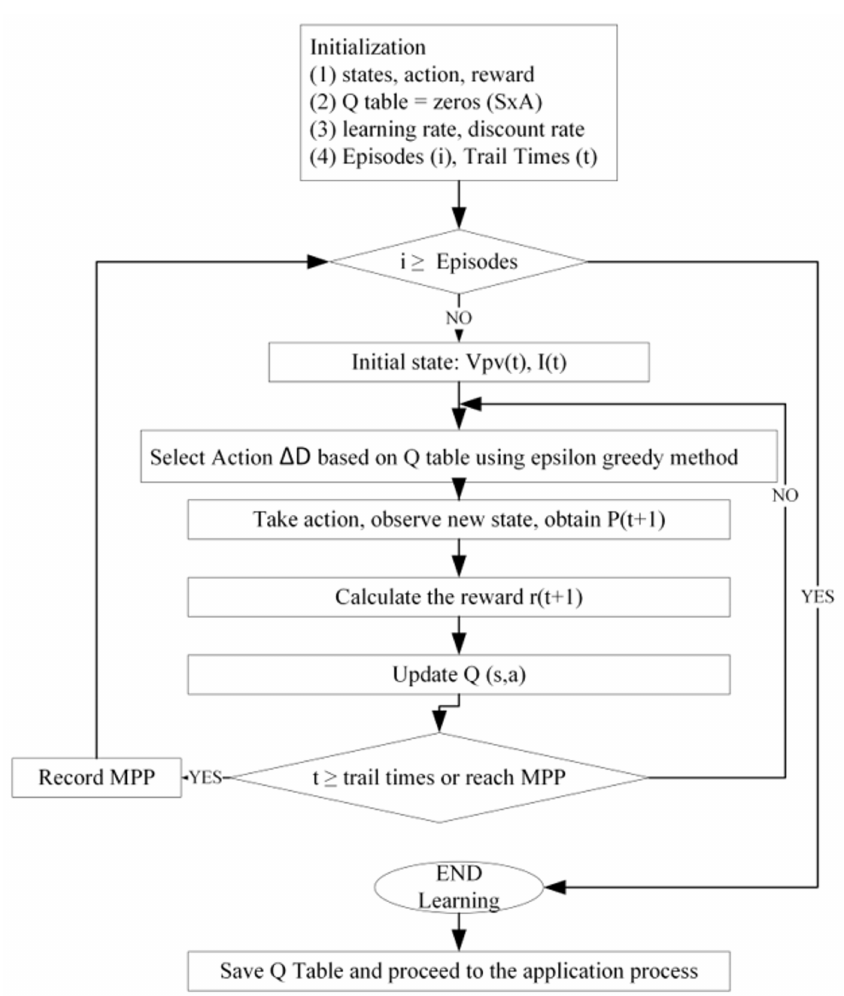
Figure 13. The learning state of the maximum power point tracking (MPPT) based Q-learning algorithm. Based on the state of art reinforcement learning in the field of MPPT control, the proposed h-POQL method aims to get the advantages of low learning time, low cost, and easy implementation in a practical system. By separating the control regions based on the irradiation and temperature, the state space can be reduced. The agent will spend less time learning the optimal policy in a small control region. In addition, the fixed step size of the duty cycle is the major problem of the P&O method in the response to the fast change of weather conditions. The Q-learning method aims to use a variable step size to define the optimal duty cycle in a specific control region. With the knowledge learned by the Q-learning agent, the P&O can change the reference input of the duty cycle so that the smaller step size of the duty cycle can be applied to track for the maximum power of the PV